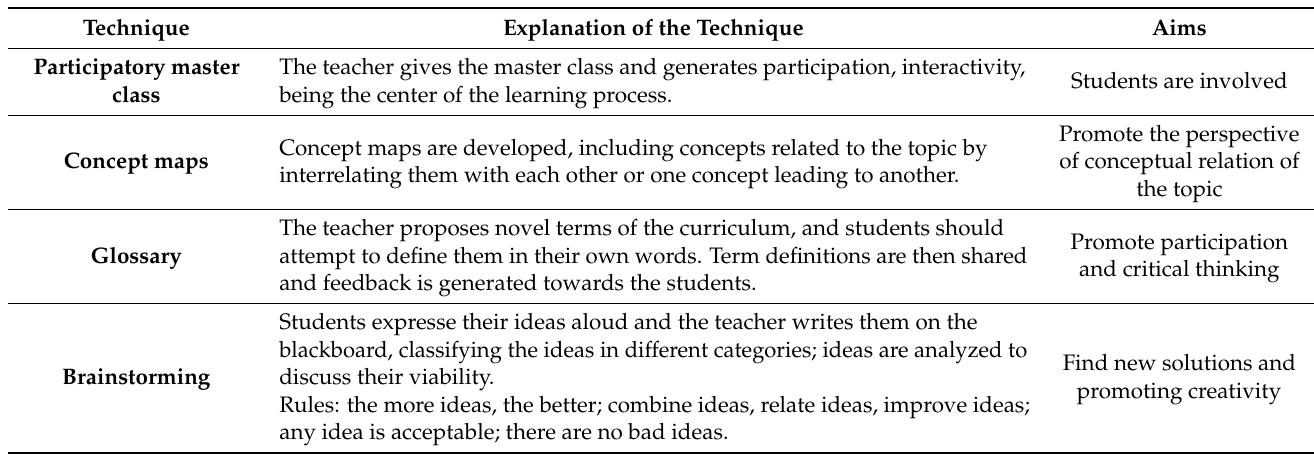
Table A2. Explanation of the techniques used in theoretical and practical sessions of the cooperative learning